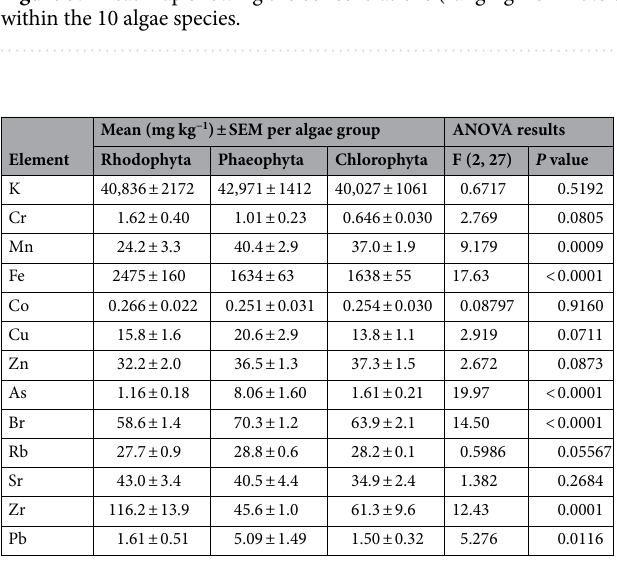
Table 7. Overall mean elemental concentration per group of algae and ANOVA